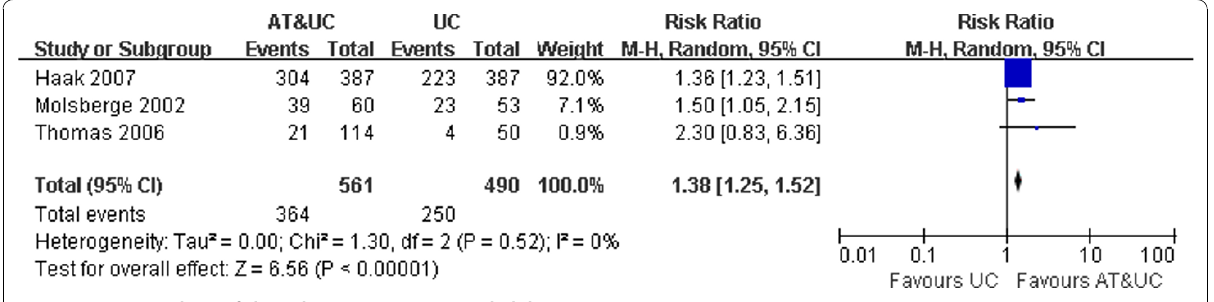
Figure 3 Meta-analysis of the risk ratio (transition probability) .